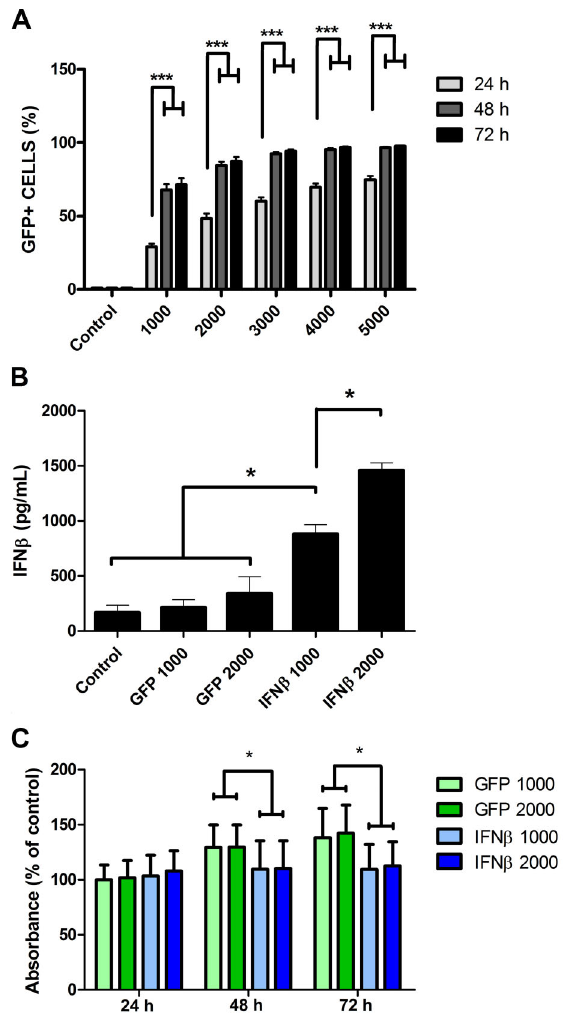
Figure 1. Transduction of mesenchymal stem cells (MSCs) with RGD-modi fi ed adenoviral vectors. A , MSCs were either not transduced (Control) or transduced with increasing multiplicity of infection (1000 to 5000) using AdRGD-PG-eGFP and the percentage of green fl uorescent protein positive cells (GFP + ) was determined by fl ow cytometry. B , MSCs were transduced using AdRGD-PG-eGFP (GFP) or AdRGD-PG-IFN b (IFN b ) and, 48 h later, accumulation of IFN b in the supernatant was examined by ELISA. C , Metabolic activity of MSCs was determined by MTT assay 24, 48, or 72 h post-transduction. Data are reported as the average and standard error of 6 ( A ) or 3 ( B and C ) independent assays. *P o 0.05, ***P o 0.001, statistical analysis was per- formed comparing individual experimental conditions with the corresponding control using the Student ’ s t -test.